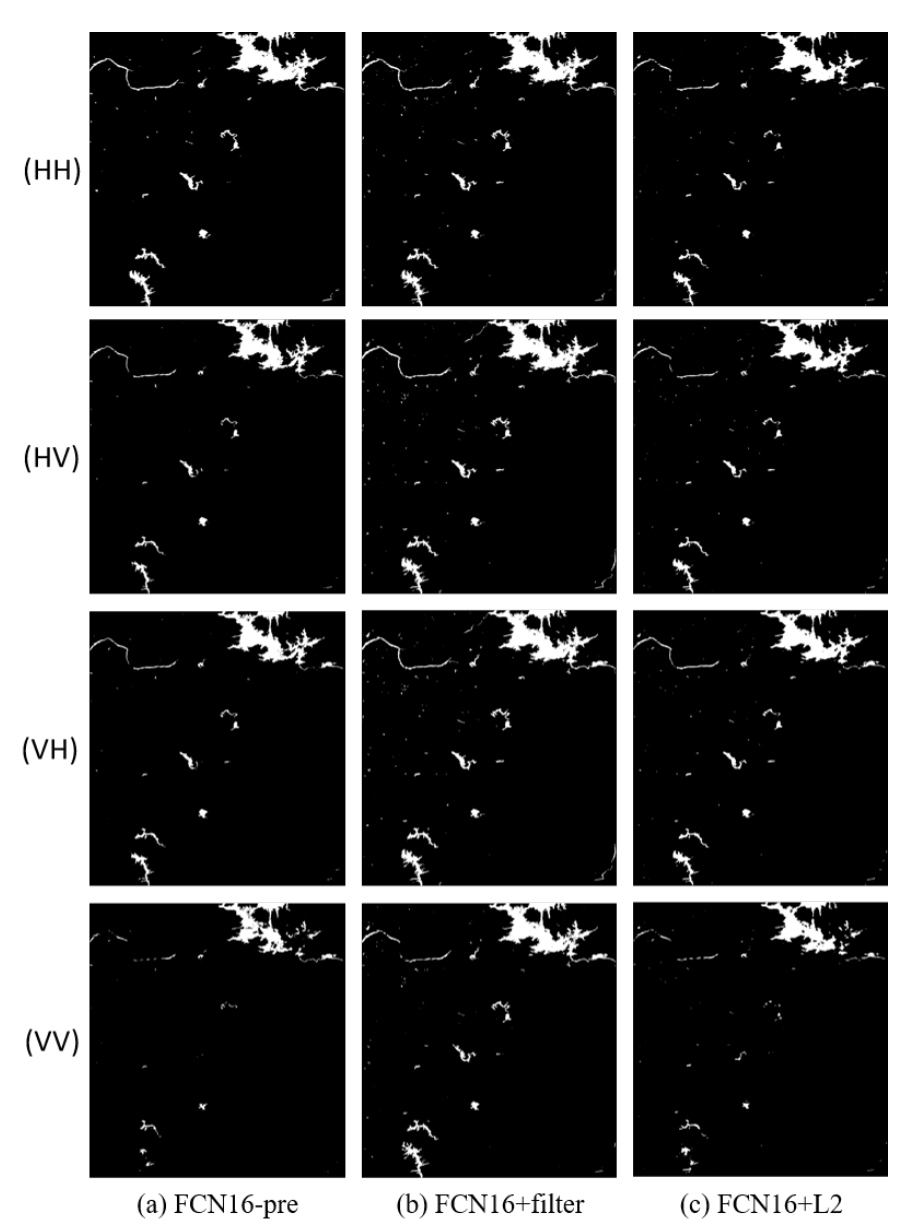
Figure 14. The results of FCN16 in three different conditions of Scene 3: ( a ) FCN16 without pre-process; ( b ) FCN16 with filtering after pre-process; and ( c ) FCN16 using L2 regular in loss